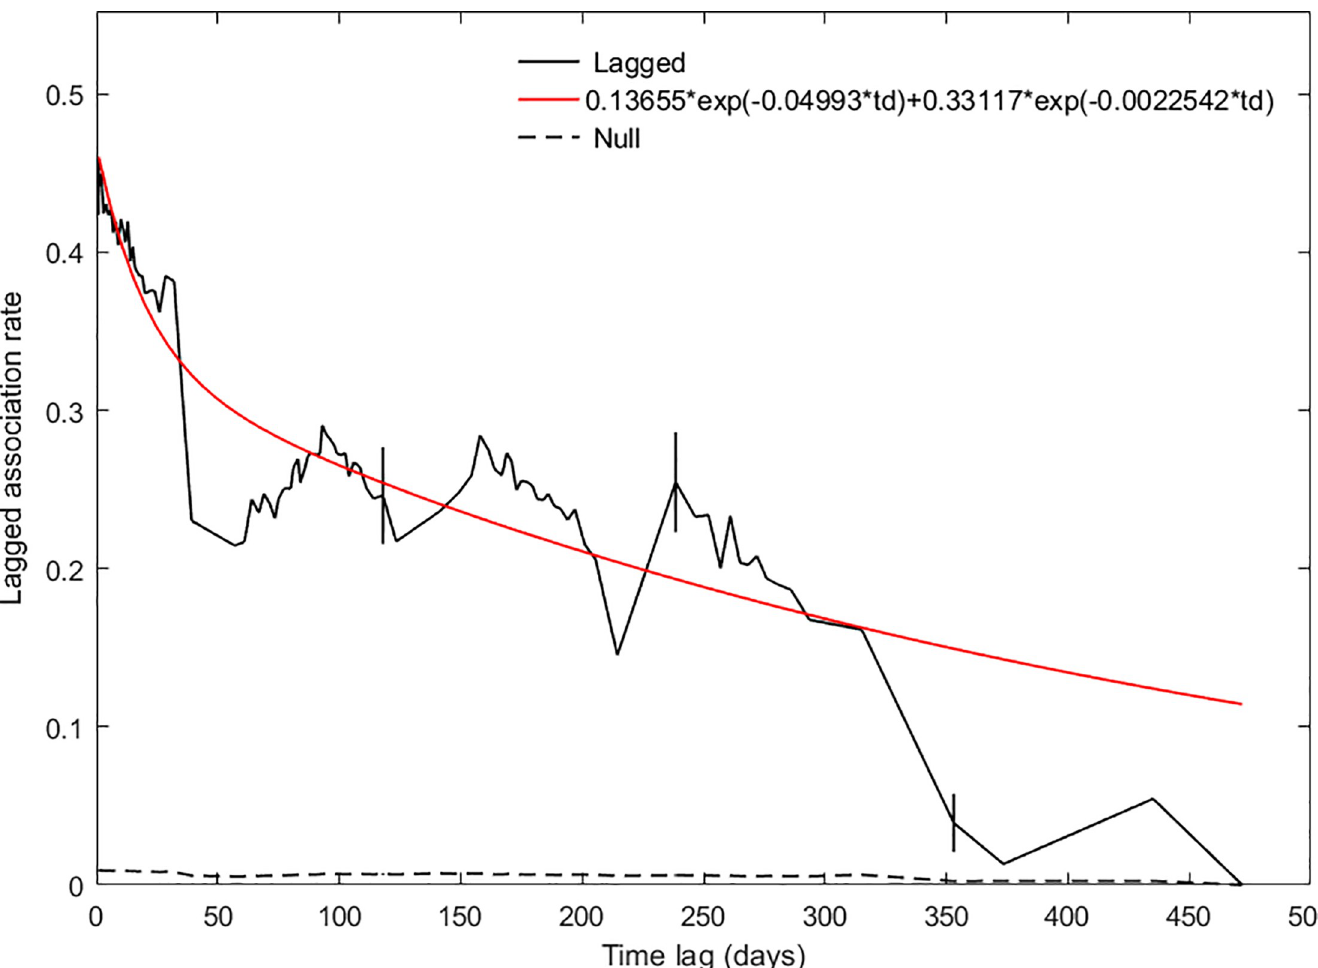
Fig 5. The probability that pairs of foxes that associated on a given day would re-associate at a later time (lagged association rate, LAR), the best-fitting exponential model and the expected association rate if associations were random (null association rate, NAR) for the whole dataset. Vertical lines show jack-knife standard